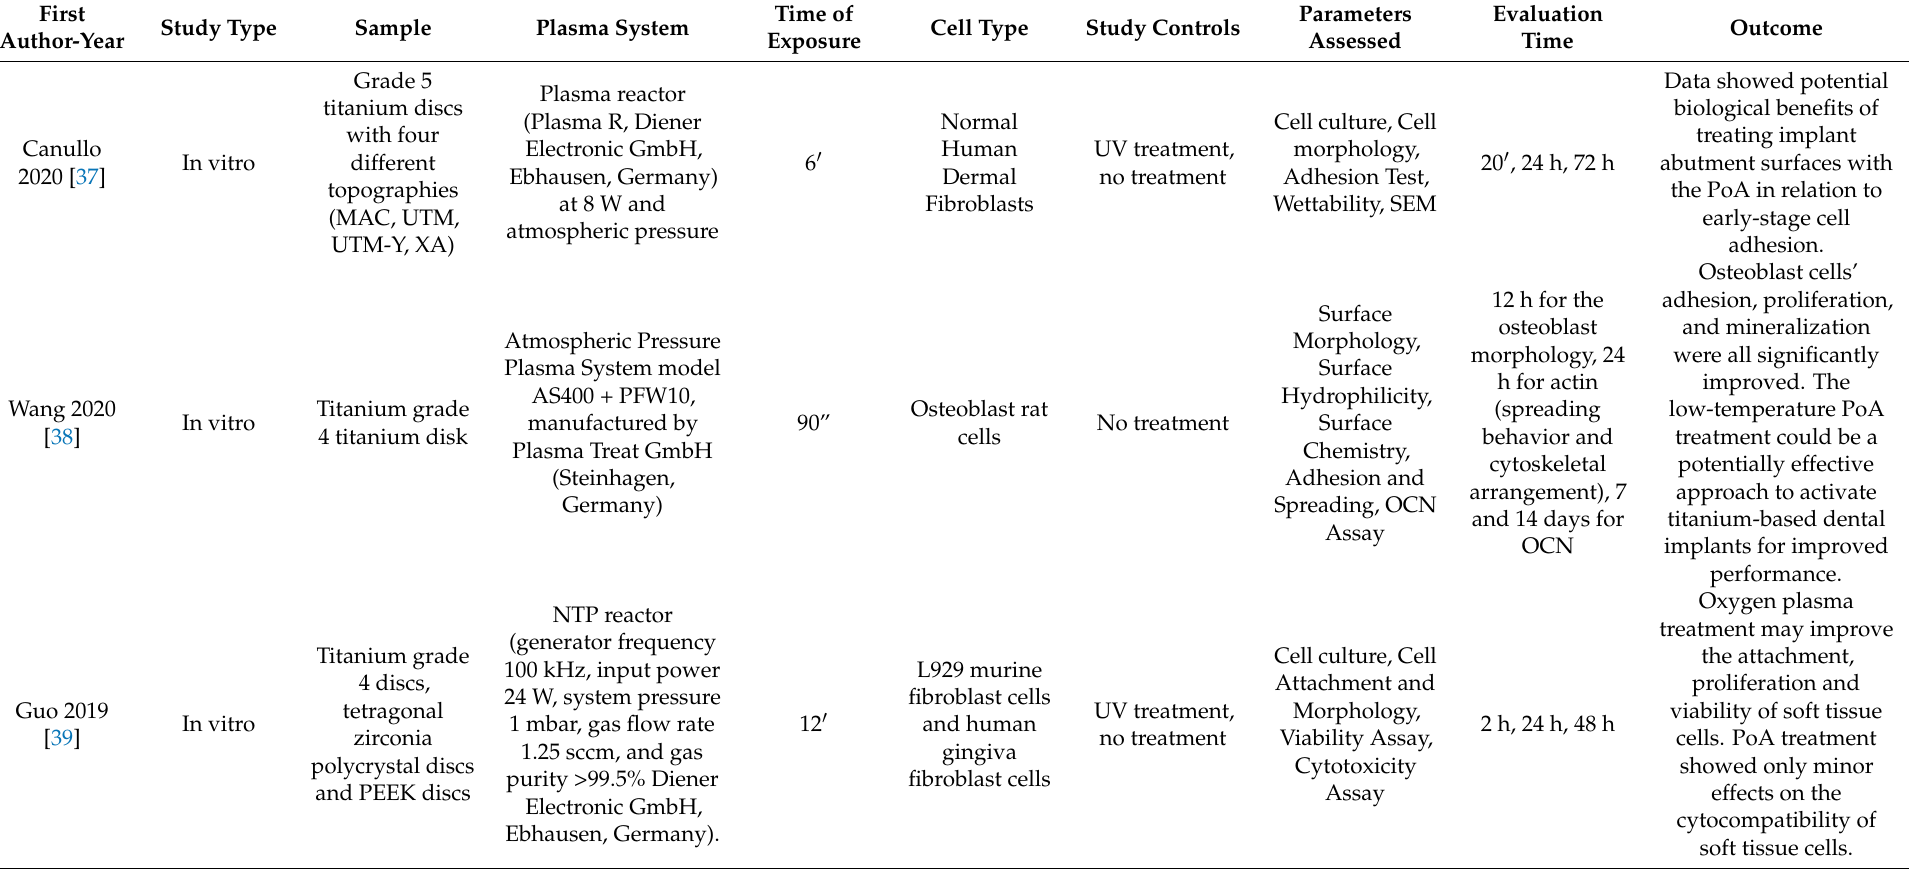
Table 3. Characteristics of the included